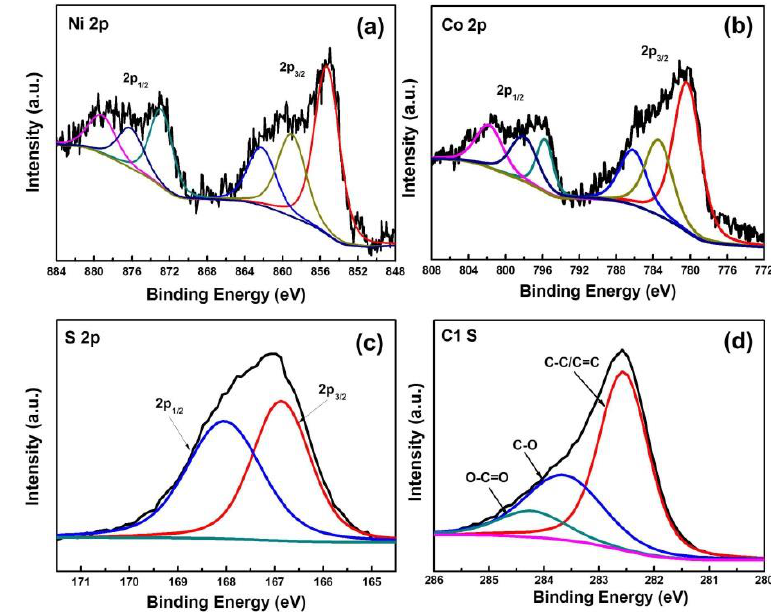
Figure 4. X-ray photoelectron spectroscopic spectra of the NiCo 2 S 4 / Ni-rGO nanocomposites: ( a ) Ni 2p; ( b ) Co 2p; ( c ) S 2p; and ( d ) C 1s spectra.